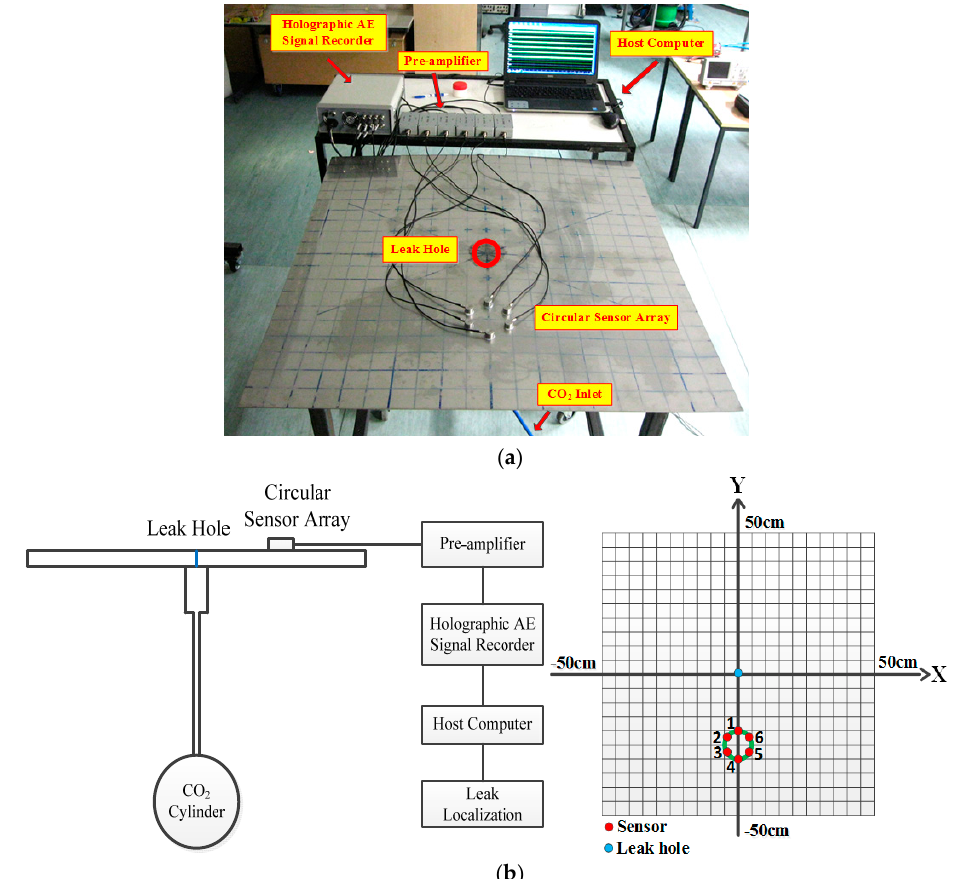
Figure 5. Experimental set-up and layout of the sensor array. ( a ) Experimental setup; and ( b ) the layout of the sensor array.